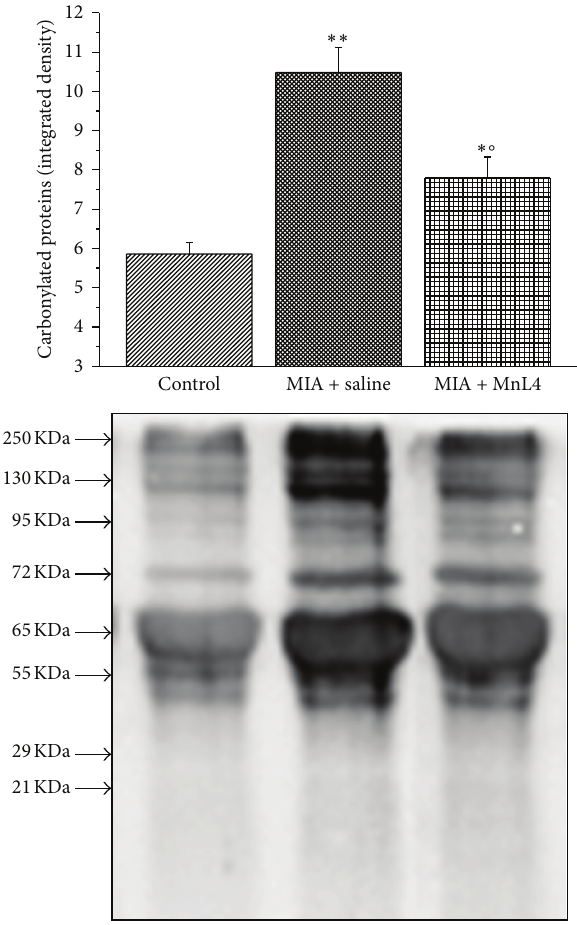
Figure 5: Effect of MnL4 (15mg kg −1 continuously infused for 15 days) on plasma oxidation levels 14 days after MIA injection (2 mg/25 𝜇 L in the left posterior tibiotarsal articulation on day 0). Immunoblot analysis was performed after a reaction with dinitrophenylhydrazine. Densitometric analysis and representative Western blot are shown. Ponceau-stained membranes were used as loading control. Each value represents the mean of 4 biological samples. ∗ 𝑃 < 0.05 and ∗∗ 𝑃 < 0.01 versus control rats; ∘ 𝑃 < 0.05 versus MIA + saline treatment.